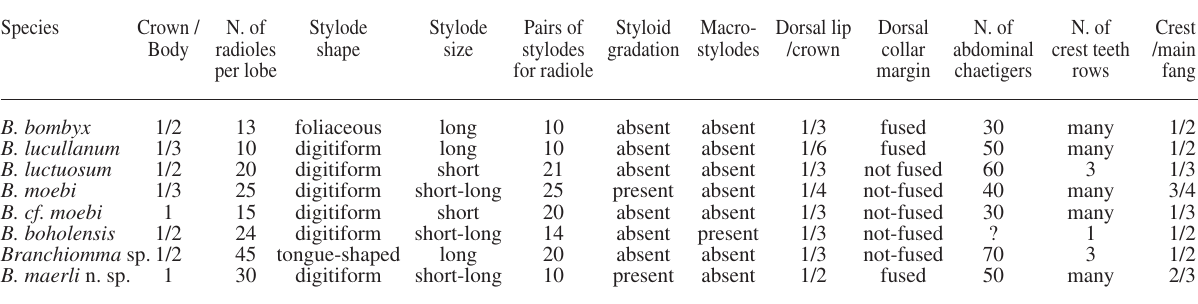
Table 1. – Comparative analysis of the main taxonomic characters of Branchiomma species from the Mediterranean Sea. The indication “short- long” in the column “stylode size” indicates the presence of different sizes along the radiole (gradation) or the presence of macrostylodes. Species Crown / N. of Stylode Stylode Pairs of Styloid Macro- Dorsal lip Dorsal N. of N. of Crest Body radioles shape size stylodes gradation stylodes /crown collar abdominal crest teeth /main per lobe for radiole margin chaetigers rows fang B. bombyx foliaceous long absent absent 1/3 fused 30 many 1/2 B. lucullanum 1/3 10 digitiform long absent absent 50